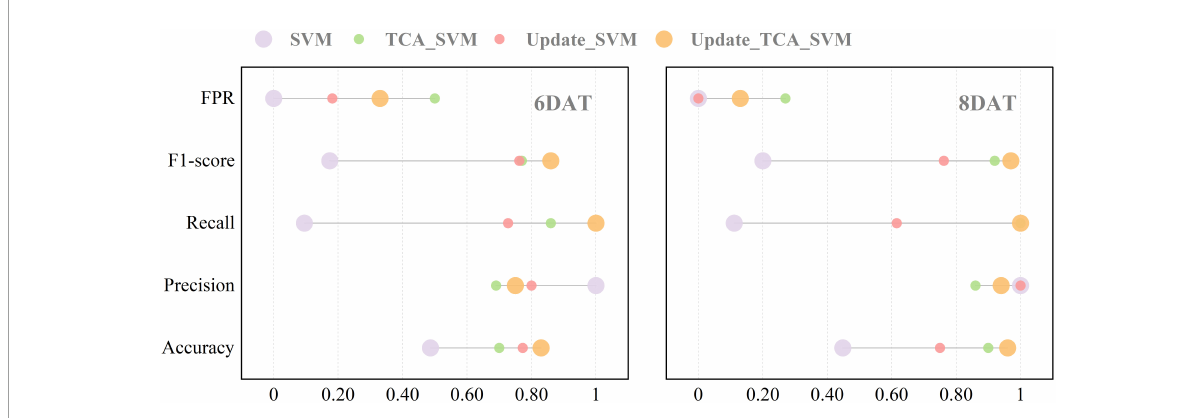
FIGURE5 Performance of four models on new target domain in transfer learning task (Exp.3 → Exp.1). SVM, support vector machine model. TCA_SVM, transfer component analysis-based support vector machine model. Update_SVM, source domain updating-based support vector